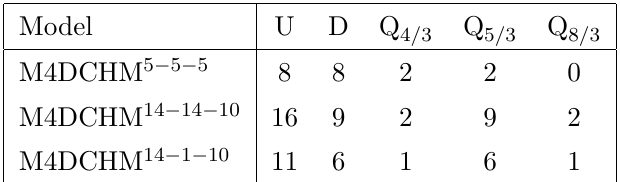
Table 1. Number of non-SM particles of a given type in each model. There are up-type (U) and down-type (D) particles, as well as particles Q